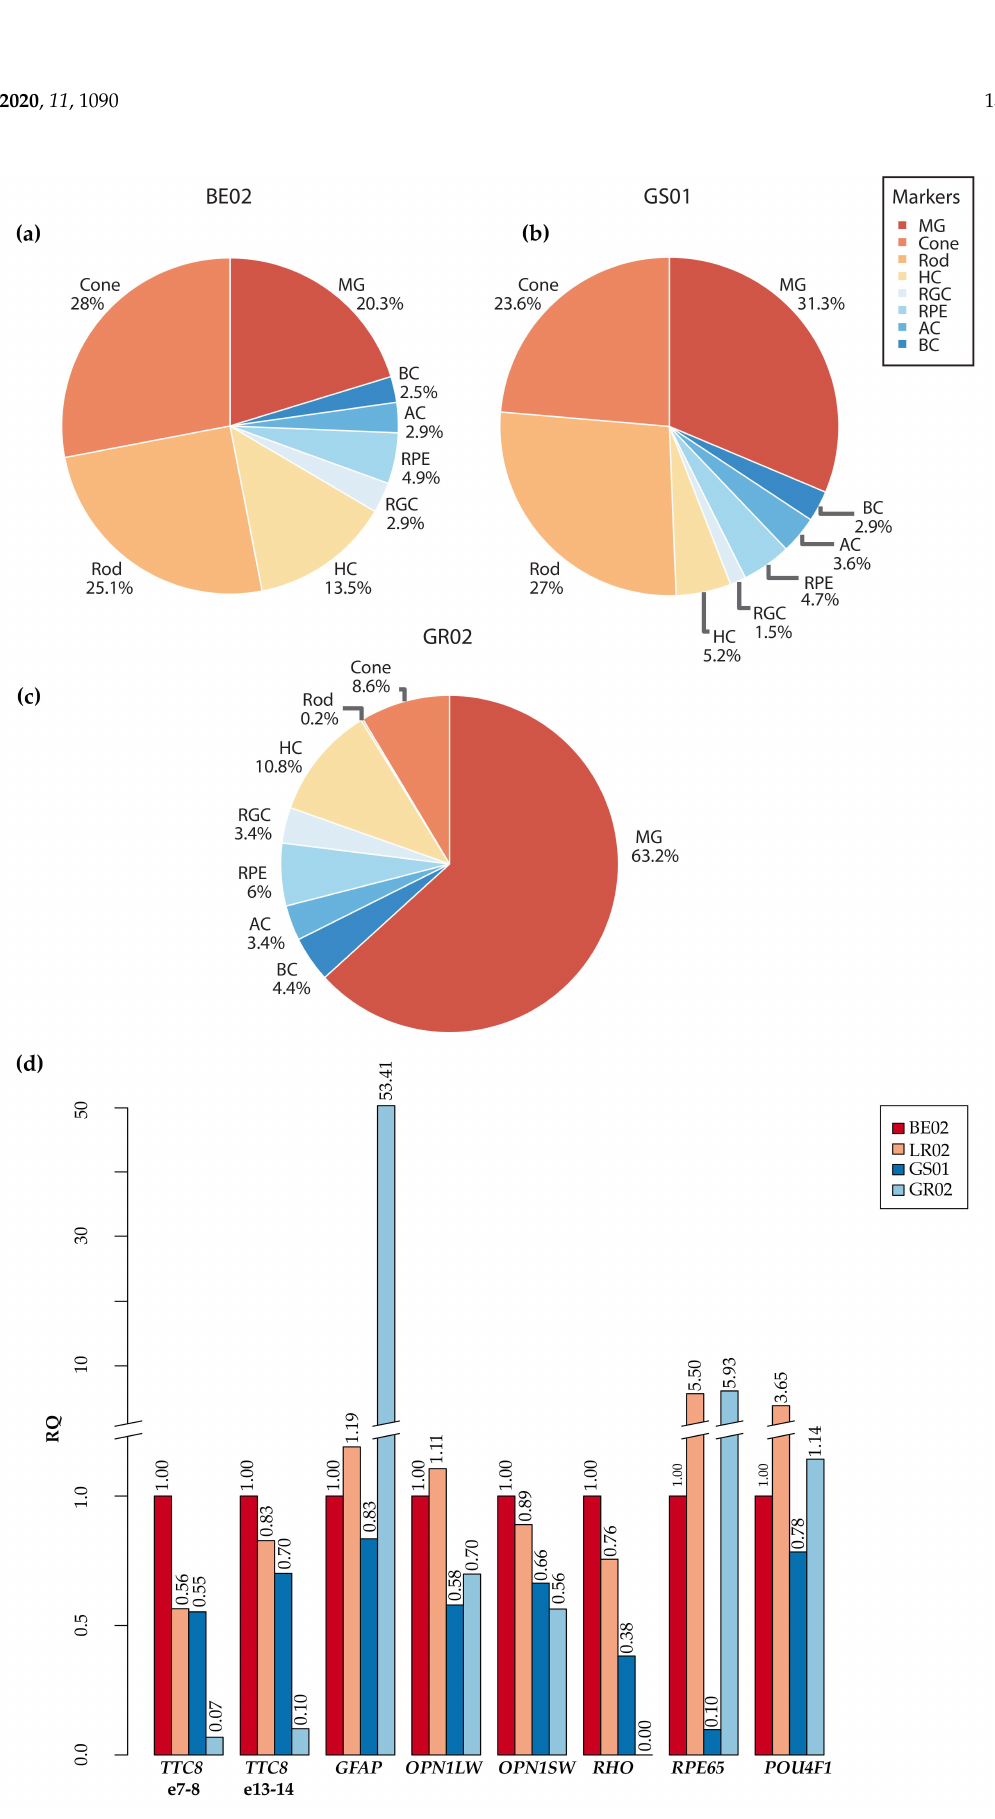
Figure 8. Expression of retinal marker genes. ( a ) The average expression of marker genes for each retinal cell type in the unaffected BE02 ( a ) and GS01 ( b ) dogs as well as the affected GR02 ( c ), based on cDNA sequencing. ( d ) Relative mRNA expression levels by quantitative RT-qPCR in two different